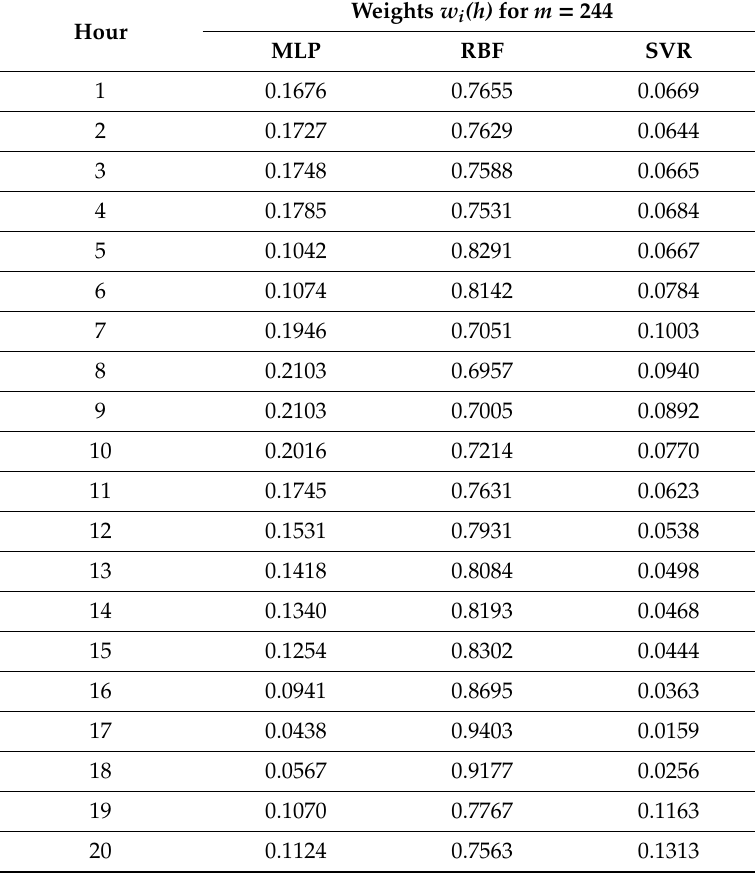
Table 6. Weights obtained based on the Formula (3), for m = 244, based on learning error for average